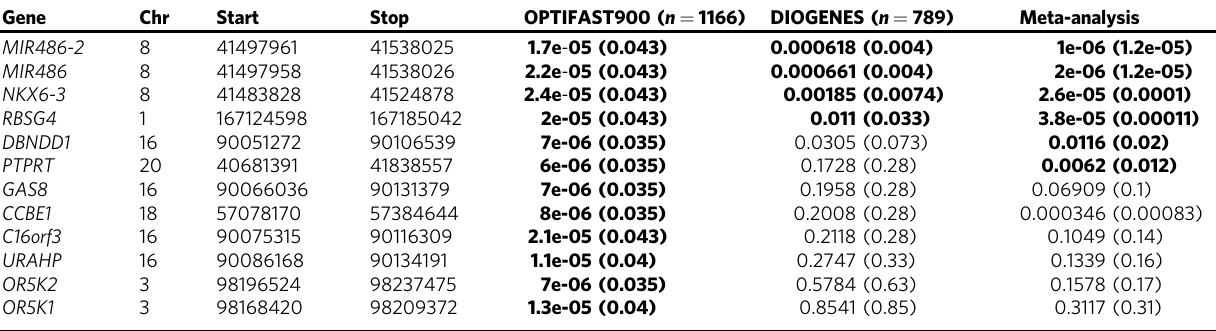
This table present gene-based association p -values for the two cohorts and their meta-analysis. False-discovery rate (FDR) adjusted p -value is indicated within parenthesis. For the discovery cohort (Optifast900), the FDR is a genome-wide FDR. For the replication cohort (DIOGENES) and the meta-analysis results, the FDR is adjusted for a two-stage analysis. FDRs less than 5% are shown in bold. Source data are provided as a Source Data fi